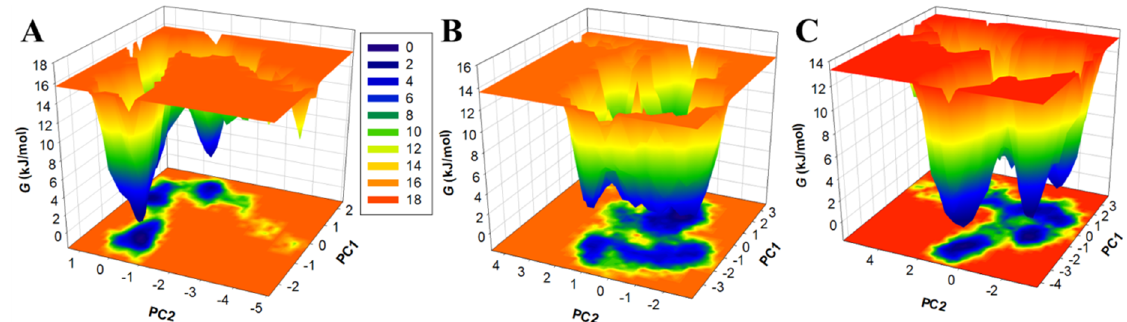
Figure 8. The FEL plots of the ( A ) free PDPK1, ( B ) PDPK1-11-Hydroxytephrosin, and ( C ) PDPK1- Torosaflavone A.